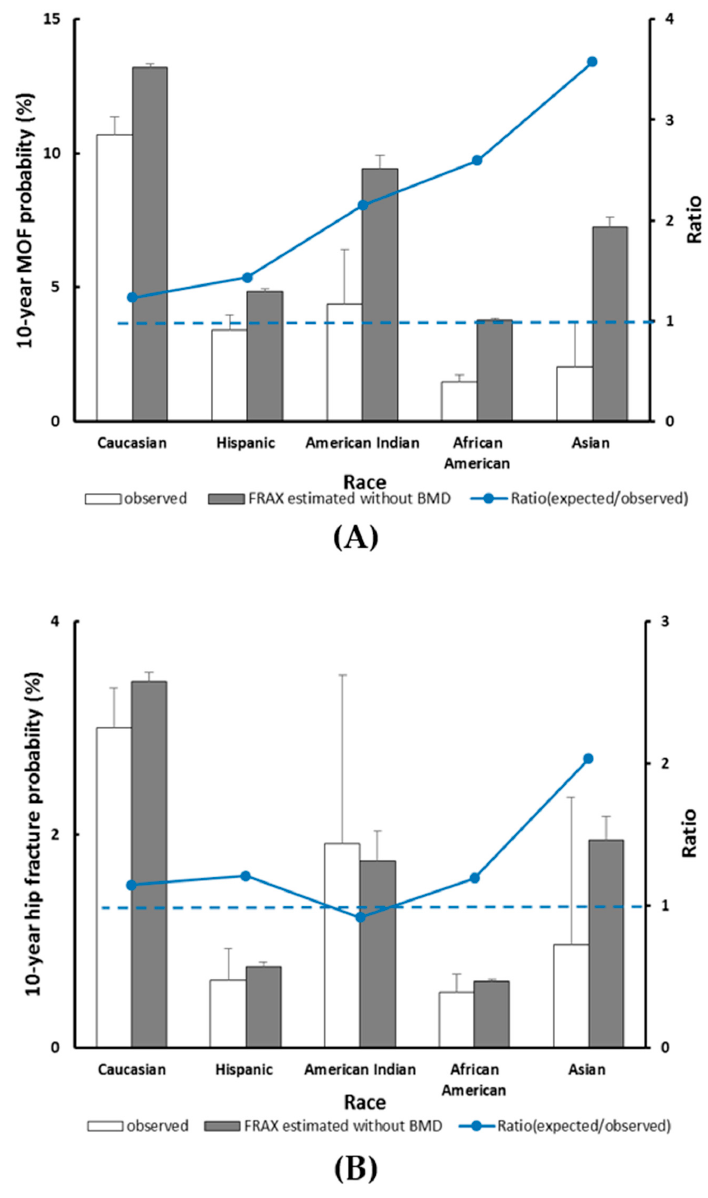
Figure 4. Observed versus predicted 10-year major osteoporotic fracture ( A ) and hip fracture ( B ) probability stratified by race. The dotted line indicates a relative ratio of 1 (reference line); ratio > 1 indicates that FRAX overestimates fracture probability.